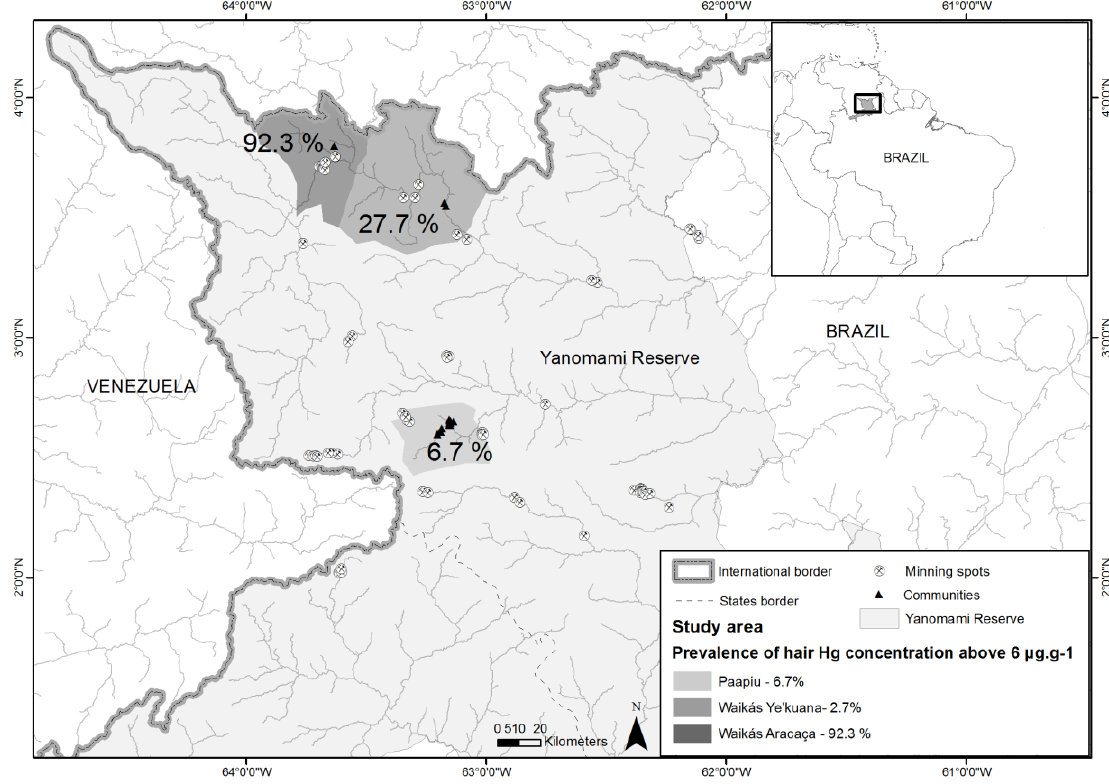
Figure 1. Study area and Prevalence of mercury concentration, considering levels above 6.0 μg·g −1 , according to villages, Yanomami Reserve, Roraima, Amazon, Brazil, 2014.